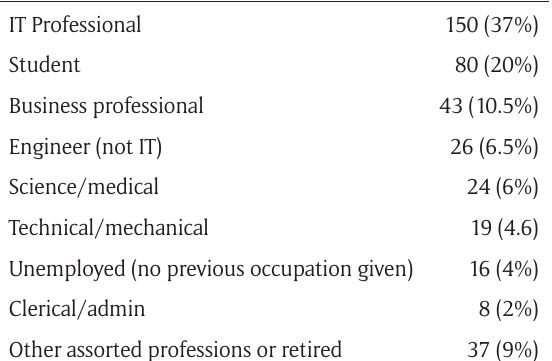
Table 3: Occupation/profession of respondents (n =